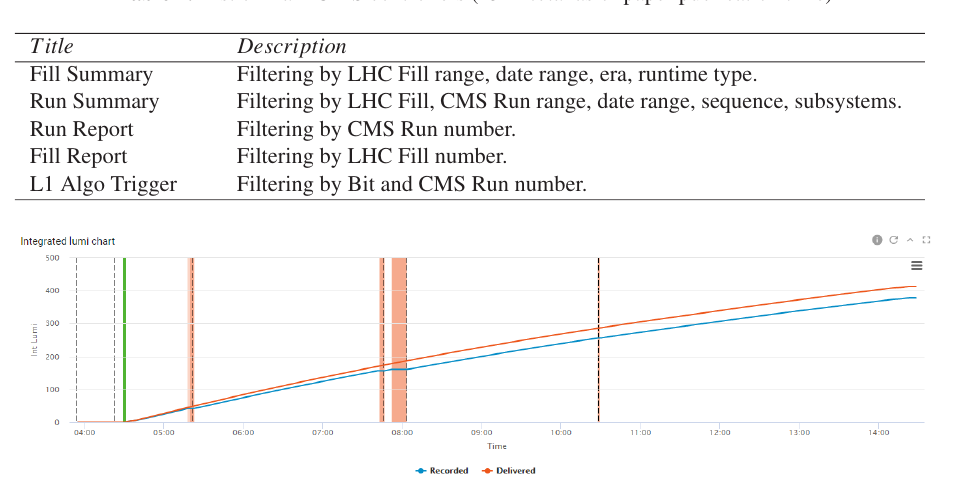
Table 2. List of main OMS controllers (13 in total as of paper publication time)